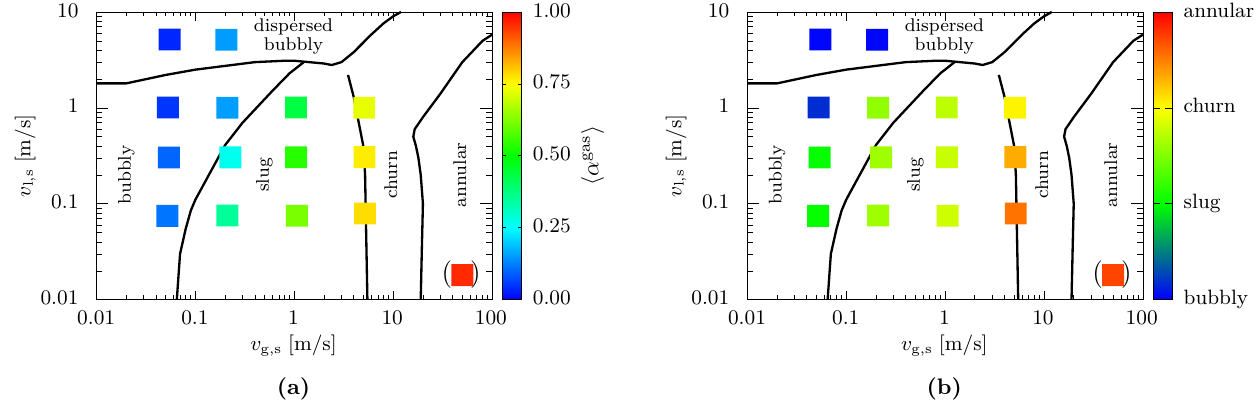
Figure 7. Comparison of measurement results from indWMS against Barnea’s [26] flow pattern map for vertical pipe orientation: ( a ) cross-sectionally averaged gas fraction; ( b ) flow